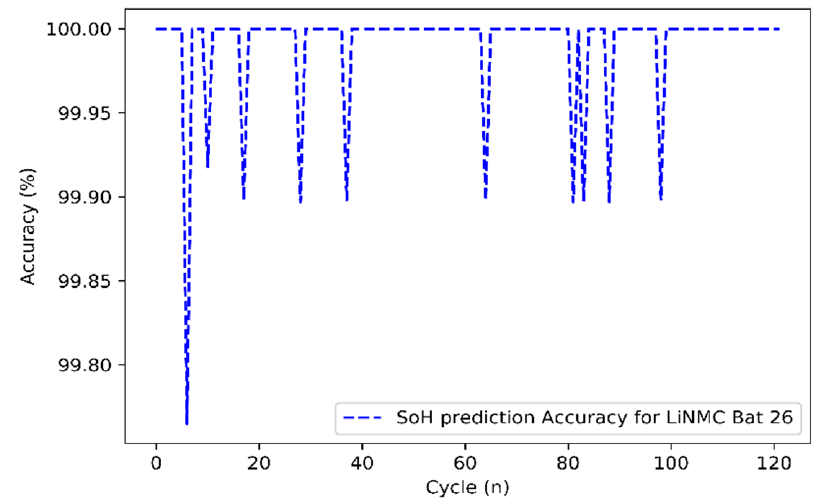
Figure 13. The accuracy in prediction of SOH for battery 26.